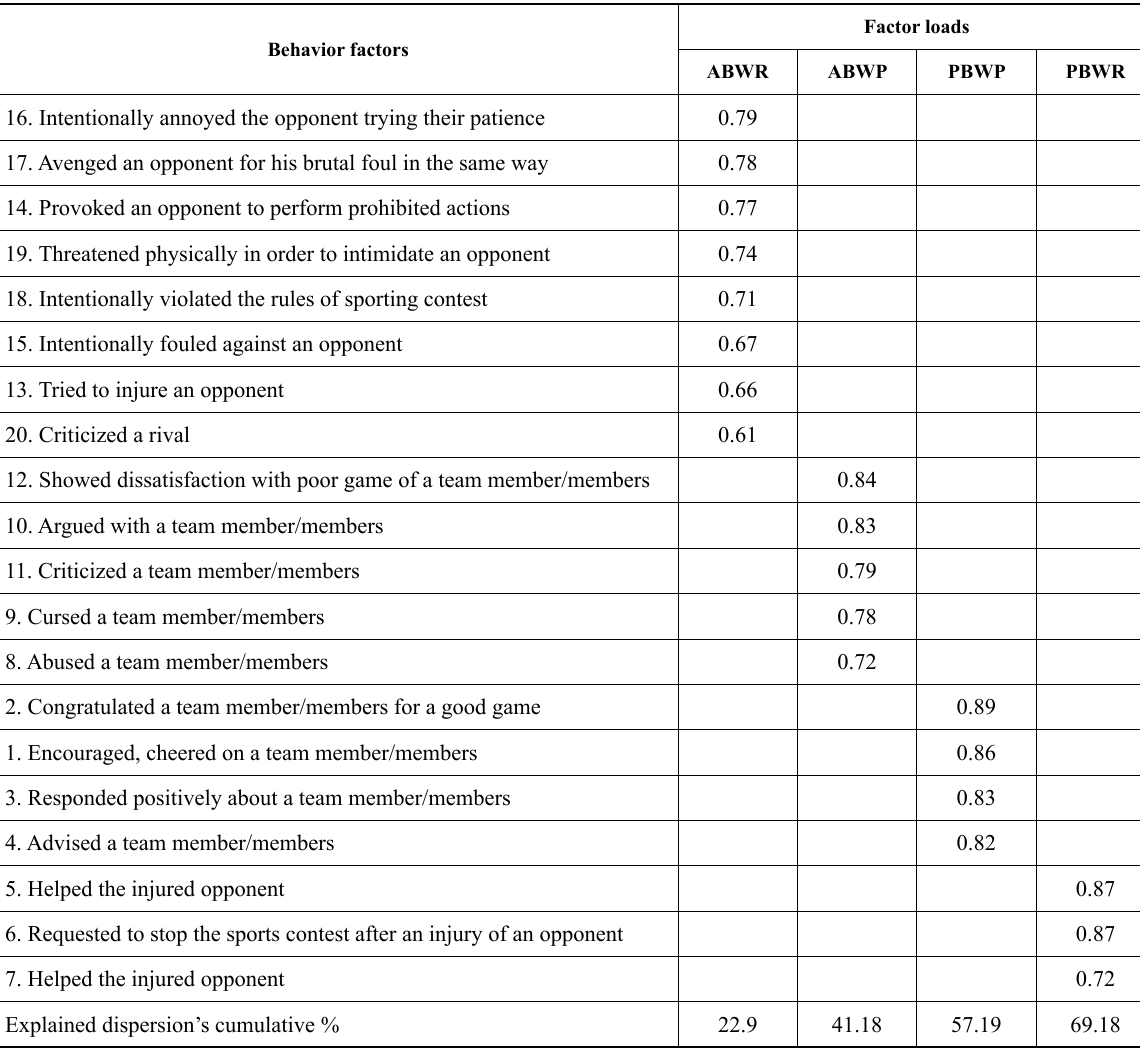
Table 2. Factors indicated by adolescents’ prosocial and antisocial behavior in sport and the dispersion explaining them (n = 201)